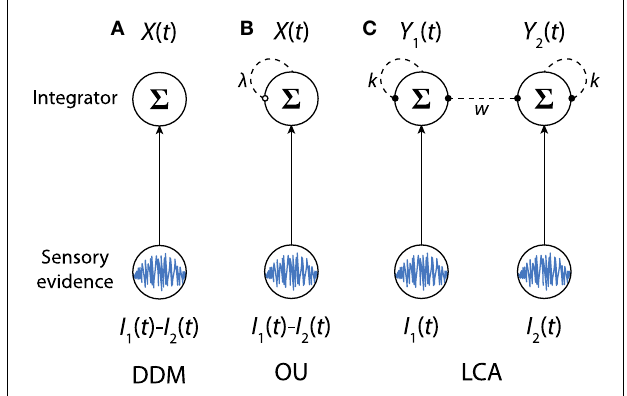
FIGURE 2 |The sequential sampling models for 2AFC tasks: (A) the DDM, (B) the OU model, (C) the LCA model. Arrows denote excitatory connections. Dashed lines with solid circle end denote inhibitory connections. For the OU model, the dashed line with an open circle end denotes the effect of the growth-decay parameter. For each model, the bottom nodes denote sensory evidence, and the top notes denote neural integrators. Model parameters are defined in Eqs